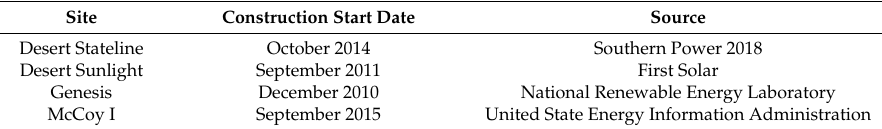
Table 2. Construction start dates for solar energy sites.